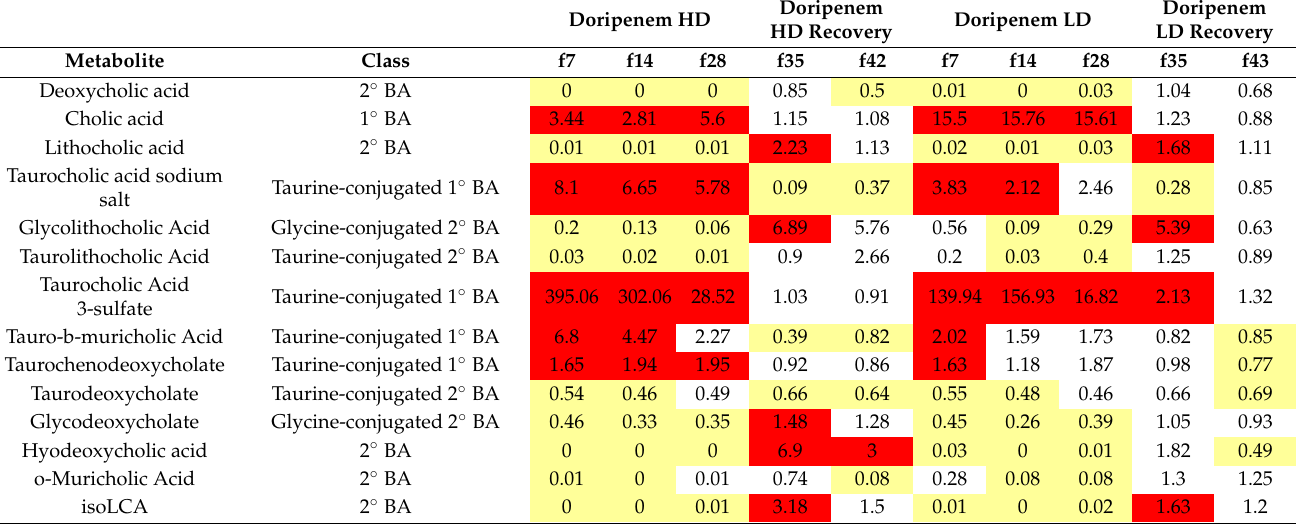
Table 4. Doripenem-induced BA fold changes in feces of female Wistar rats (N = 5 per group) dosed with 100 (LD) and 1000 (HD) mg/kg bw/day observed on days 7, 14, and 28 (f7, f14, and f28) and on days 35 and 42 (f35 and f42) for the recovery group. Statistically significant changes (Welch t -test; p -value < 0.05) are shown where red boxes mean an increase, yellow boxes mean a significant decrease, and white boxes indicate an insignificant change in the respective fecal